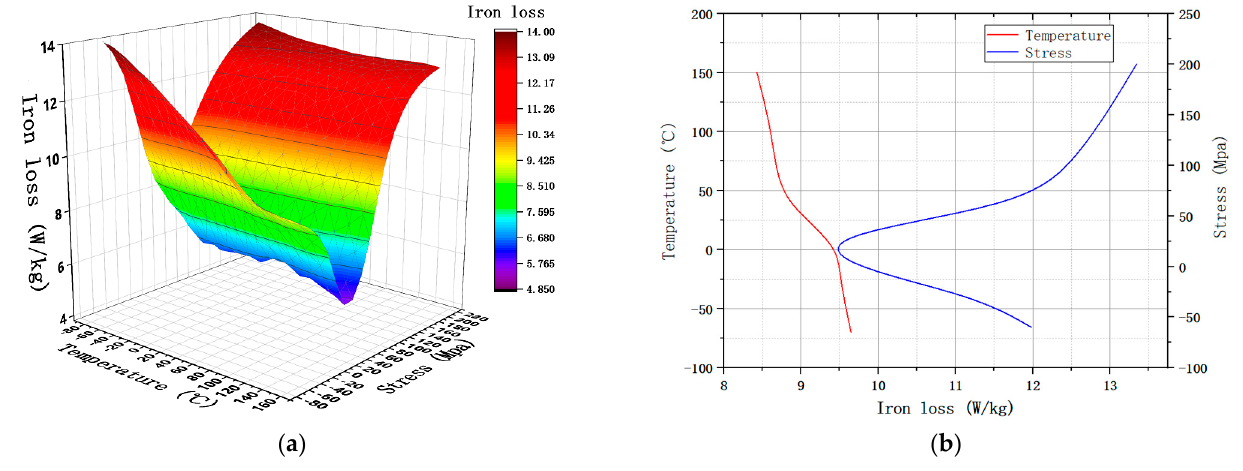
Figure 4. Iron loss under 400 Hz and 1 T. ( a ) The trend of P under MPF; ( b ) P under